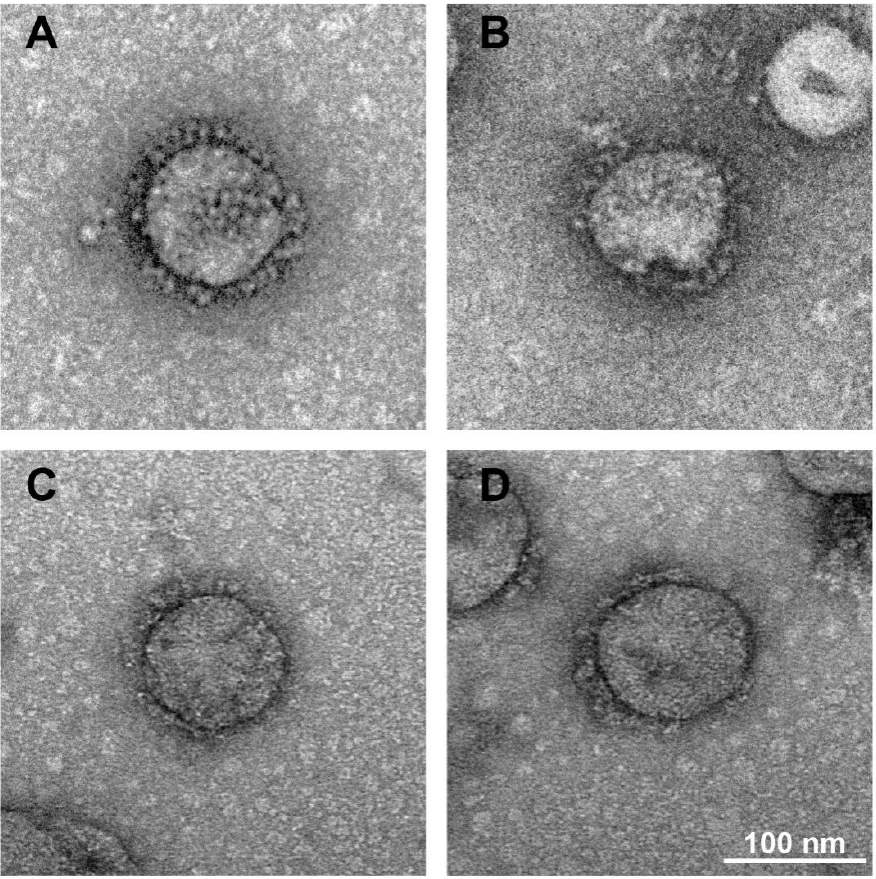
Figure 2. Electron microscope images of the morphology of different inactivated virus samples. ( A ) Formaldehyde-inactivated. ( B ) Formaldehyde + BPL-inactivated. ( C ) BPL-inactivated. ( D ) BPL + BPL-inactivated. Scale bar, 100 nm.